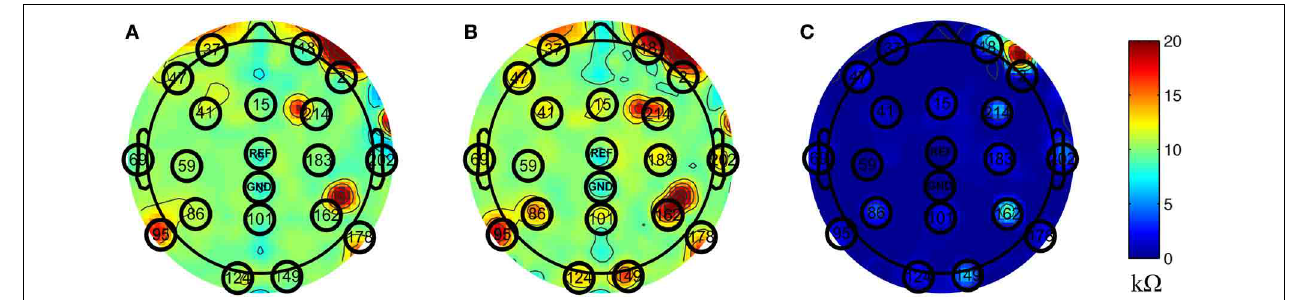
FIGURE 2 | Topographic maps of measured impedance. The numbers shown on the topographic maps are channel numbers. The conventional channels along with the reference and ground channels are highlighted with black circles. The color indicates the measured